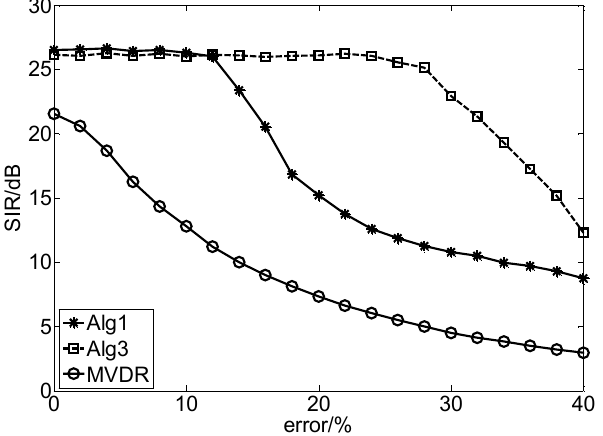
Figure 2. Comparison of the performance versus the error of DOA by using different algorithms.